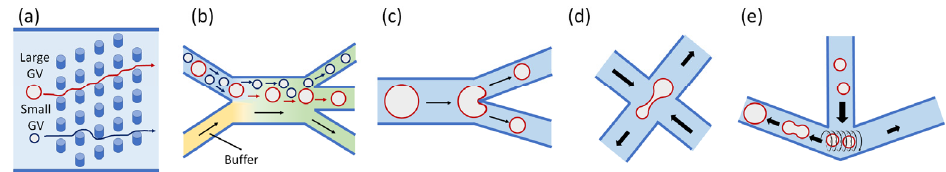
Figure 3. Schematic illustrations of microfluidic devices for size sorting, purification, and manipulation: ( a ) deterministic lateral displacement, ( b ) pinched-flow fractionation, ( c ) Y-junction for splitting GVs, ( d ) cross-road for holding and stretching GVs, and ( e ) anchor-shape junction for vesicle fusion.